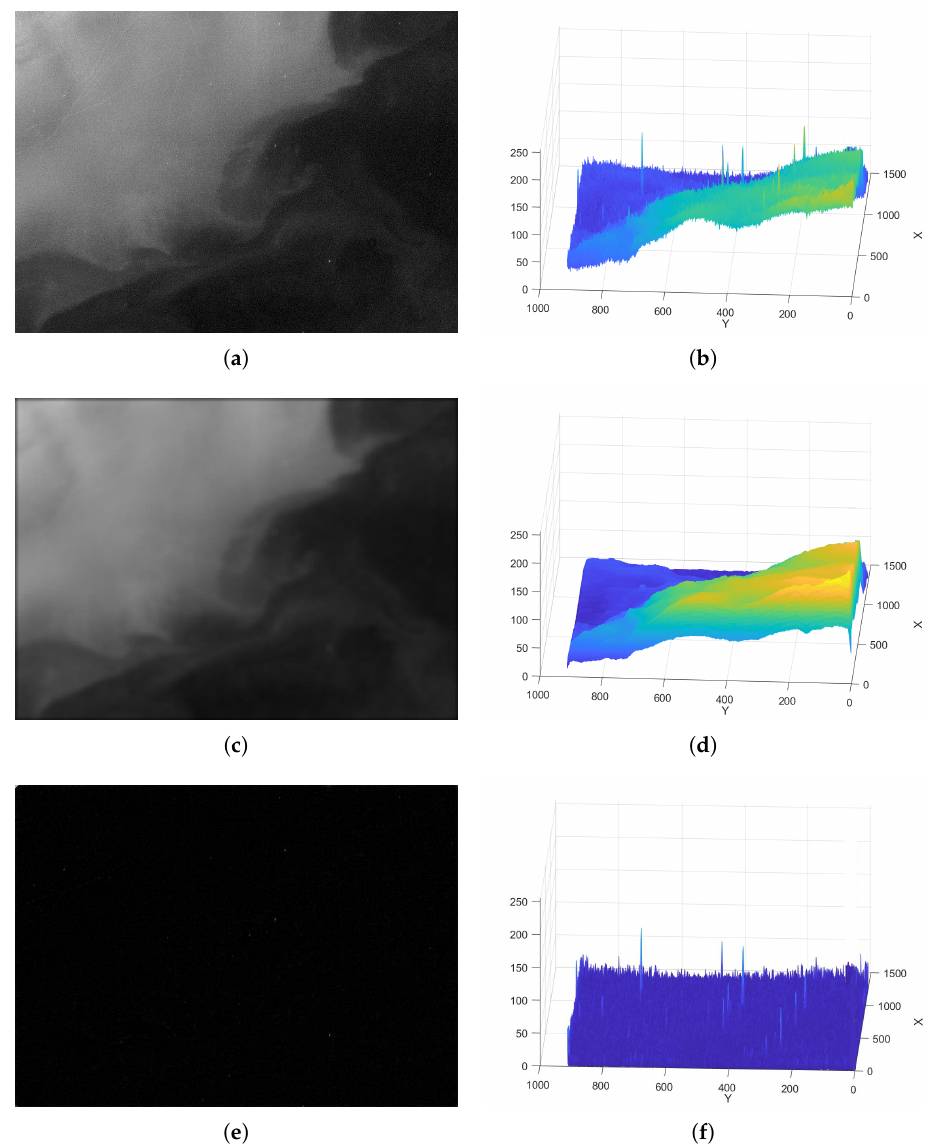
Figure 8. ( a , b ) are the original image and its 3D gray distribution map; ( c , d ) are the filtered image and its 3D gray distribution map; ( e , f ) are the preprocessing result map and its 3D gray distribution